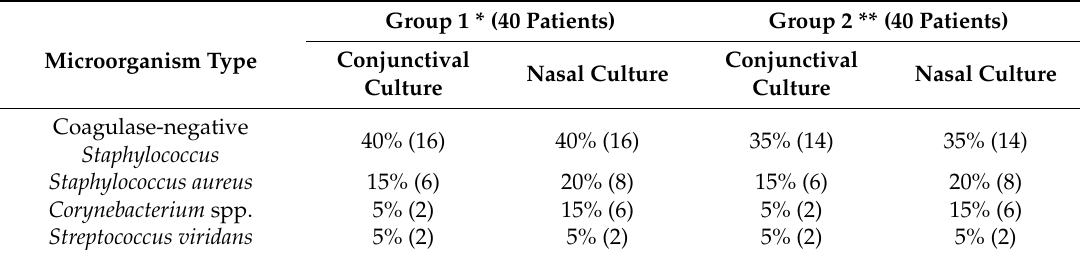
Table 1. The number of cultured organisms prior to Schirmer test in groups 1 and 2 for both conjunctival and nasal cultures.